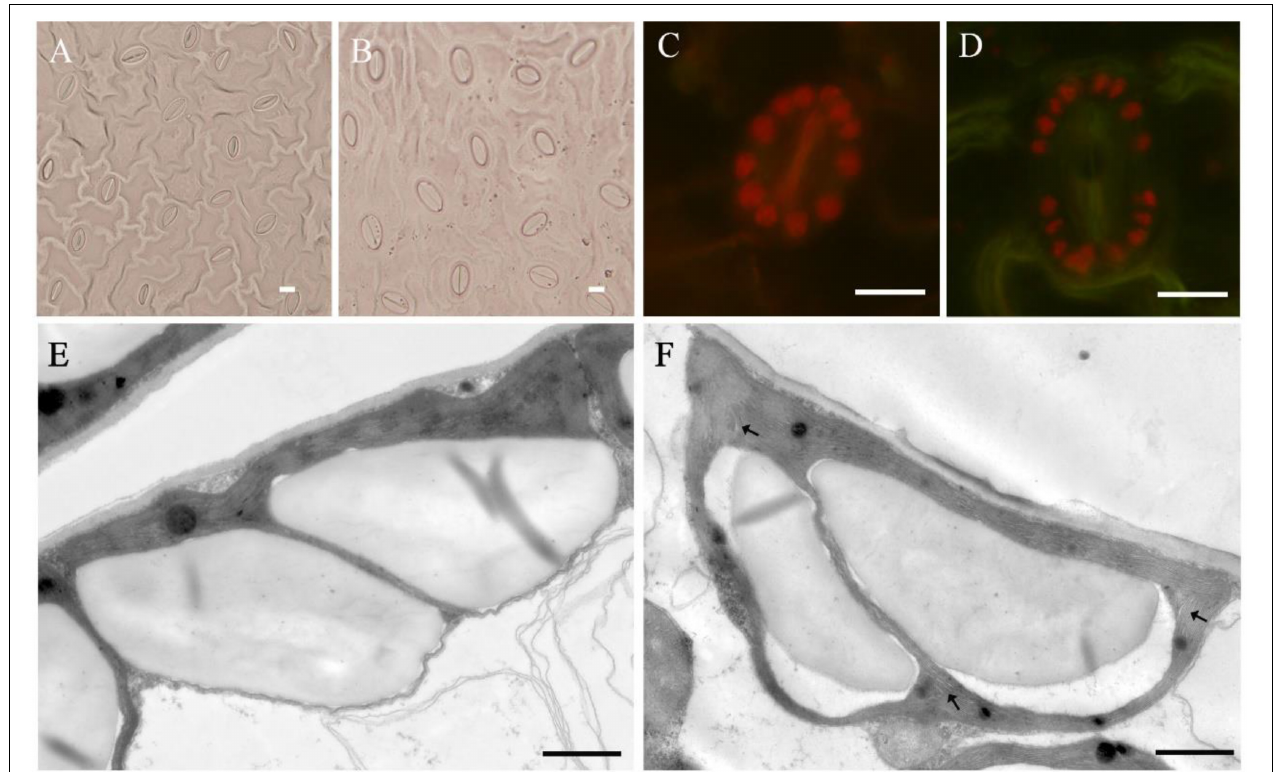
FIGURE 5 | Stomatal and chloroplast characteristics of tetraploids and diploids in E. urophylla. Stomata in the leaf of diploid (A) and tetraploid (B) ; chloroplast number in stomata of diploid (C) and tetraploid (D) ; ultrastructure of mesophyll cell chloroplasts of the diploid (E) ; and tetraploid (F) . Arrows indicate sparse stroma lamella ( A–D , bar = 10 µ m; E,F , bar = 1 µ m).